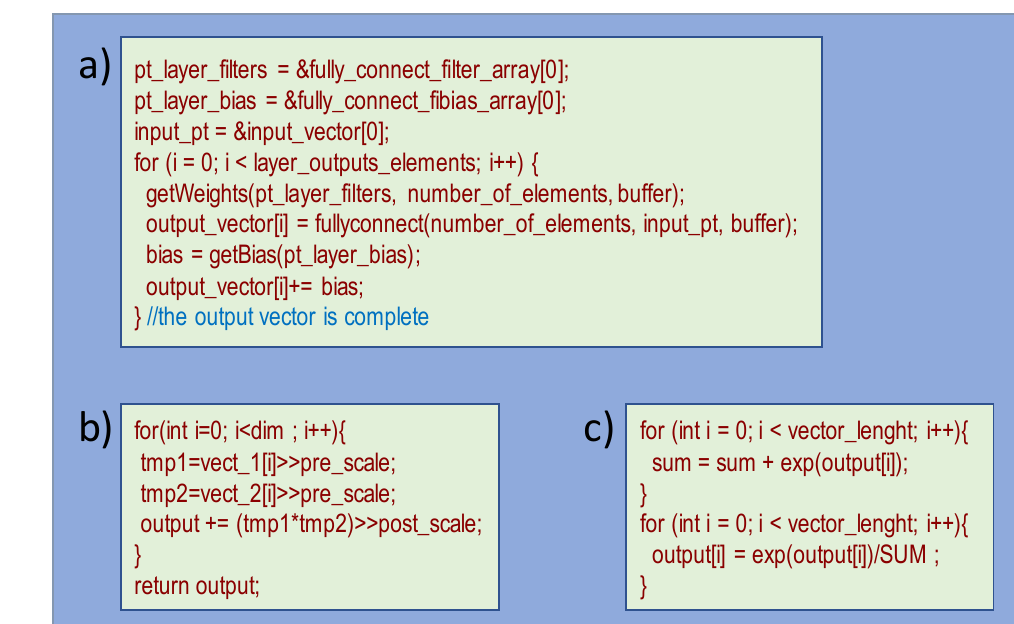
Figure 9. ( a ) Fully-connected layer in generic C code; ( b ) Fully-connect inner operations; ( c ) Softmax layer inner operations (Fully-connected Layer: 19, 20, 21; Softmax Layer: